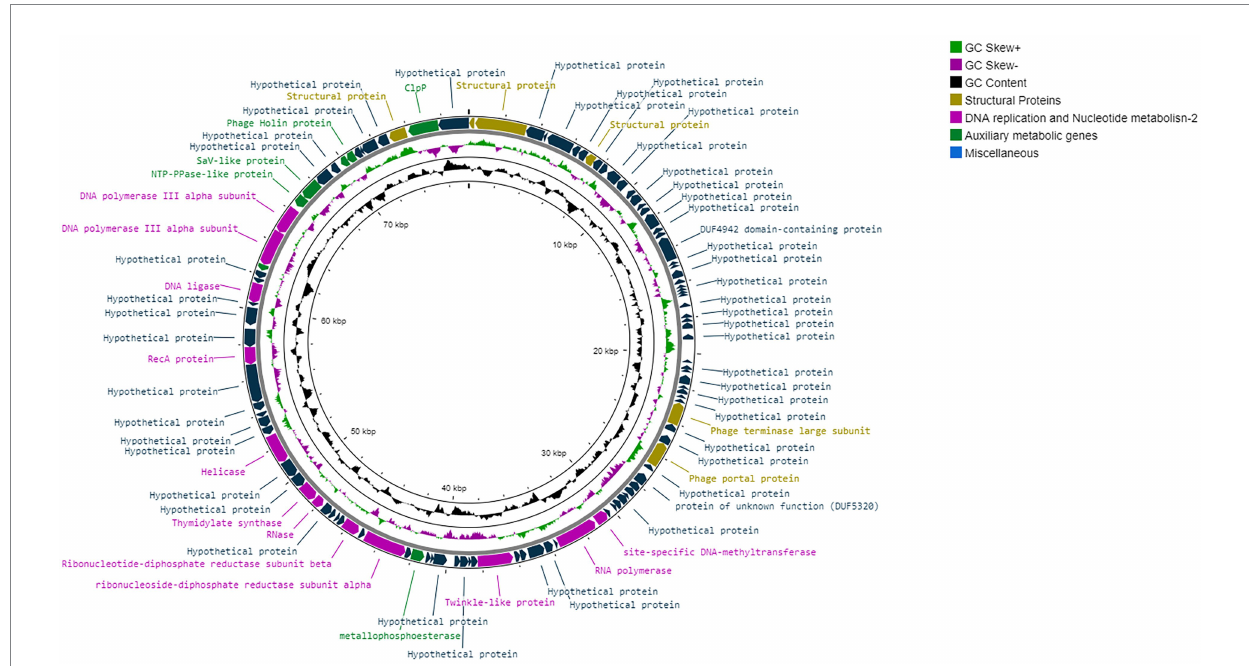
FIGURE 10 Visual circular representation of Tenacibaculum phage Larrie’s genome. The GC content is represented by the inner black line and the GC skew by the inner purple/green line. The predicted ORFs are presented as arrows. The color of the ORFS refers to annotated biochemical function; phage structural proteins (olive green), DNA replication, repair, and recombination related proteins (purple), miscellaneous proteins (light green), Hypothetical proteins (dark green).